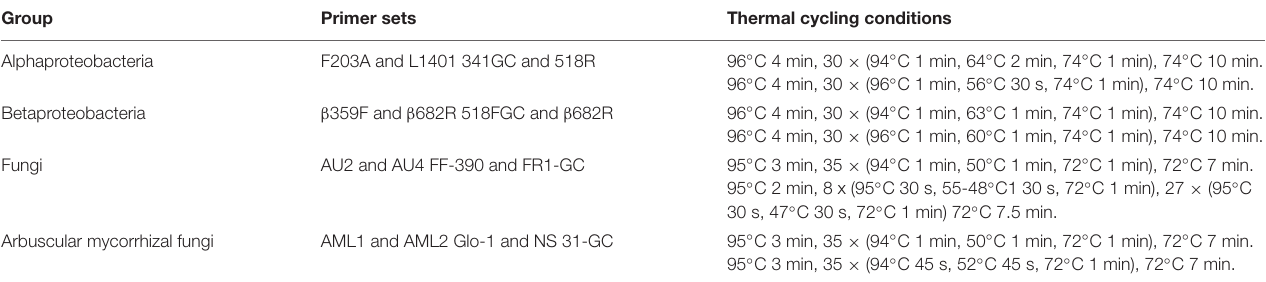
TABLE 3 | PCR primers and thermal cycling conditions used for each target group in preparation for denaturing gradient gel electrophoresis (DGGE).